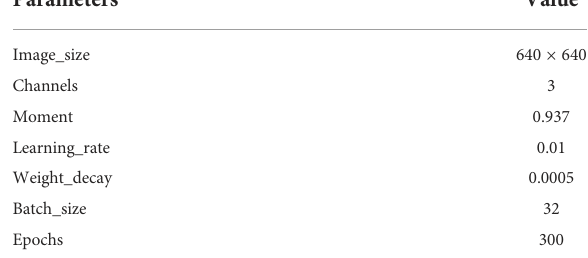
TABLE 1 Experimental parameter